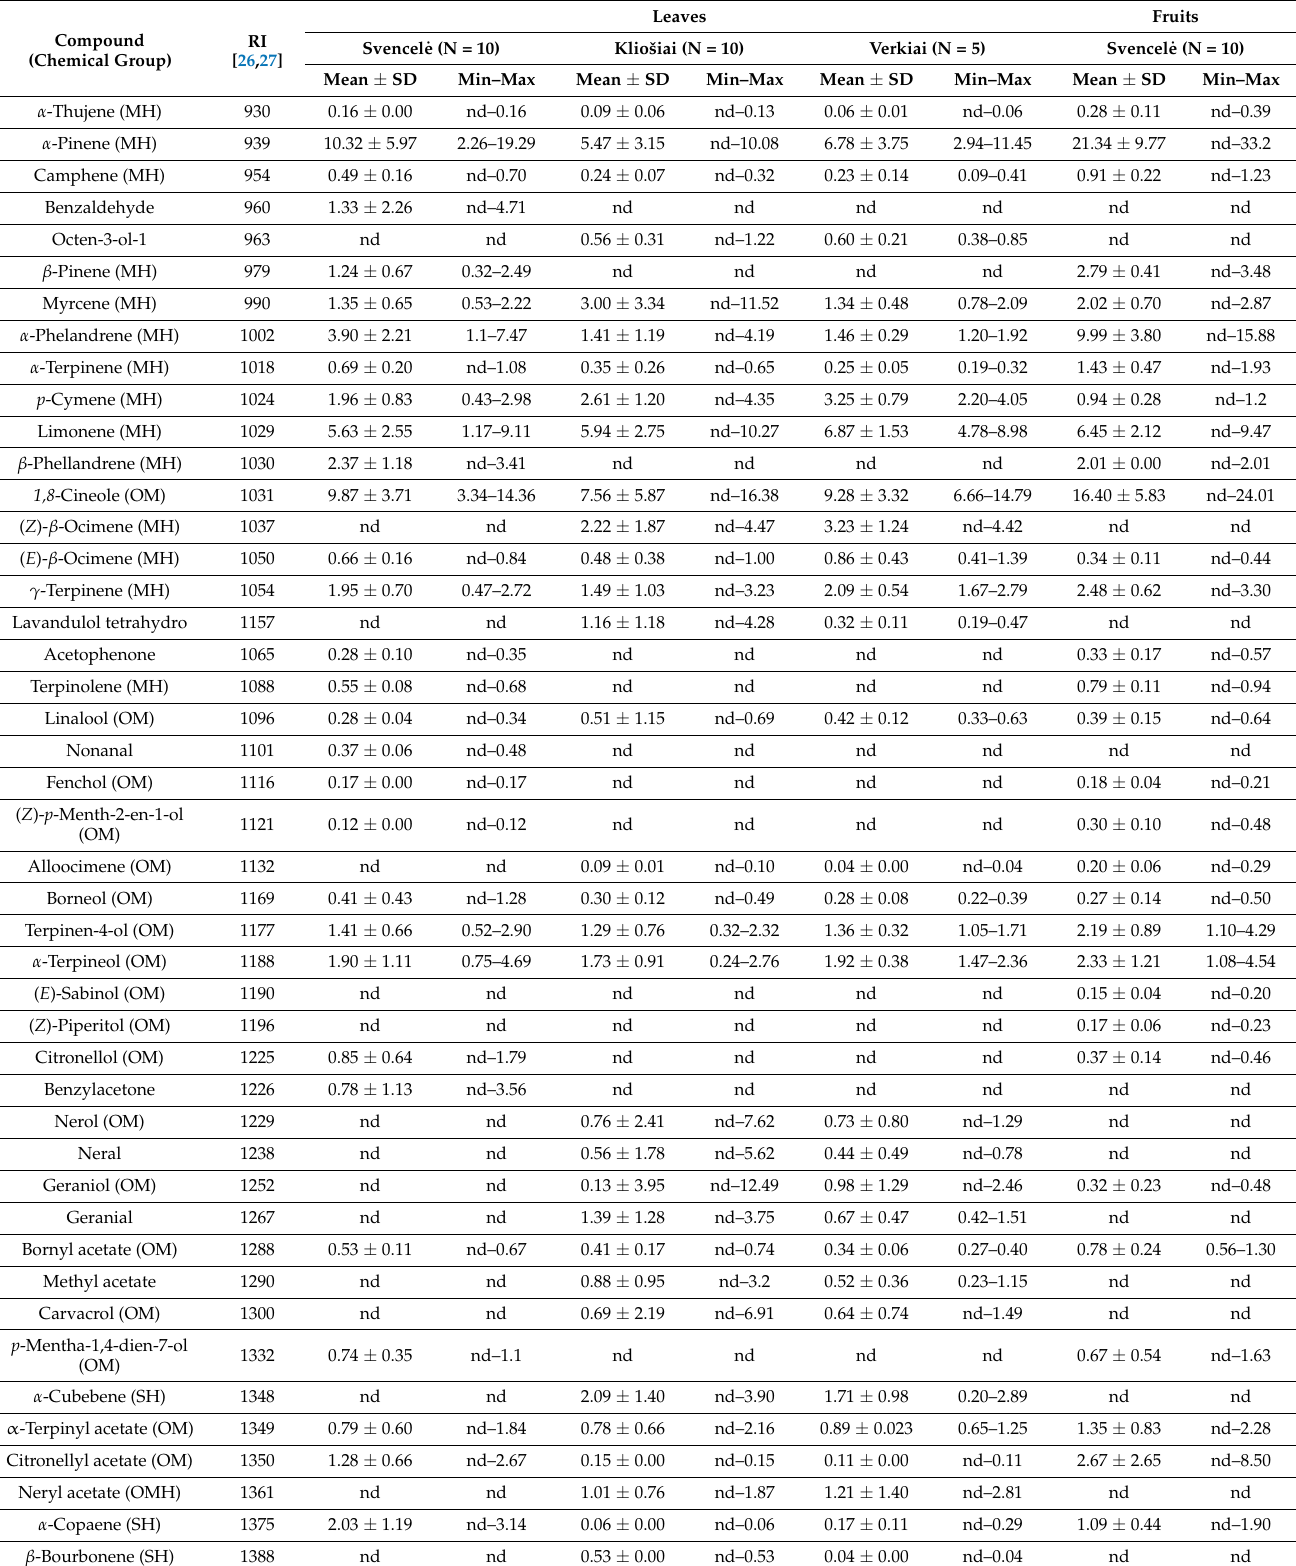
Table 2. Chemical composition of the essential oils in the leaves and fruits of Myrica gale growing in different